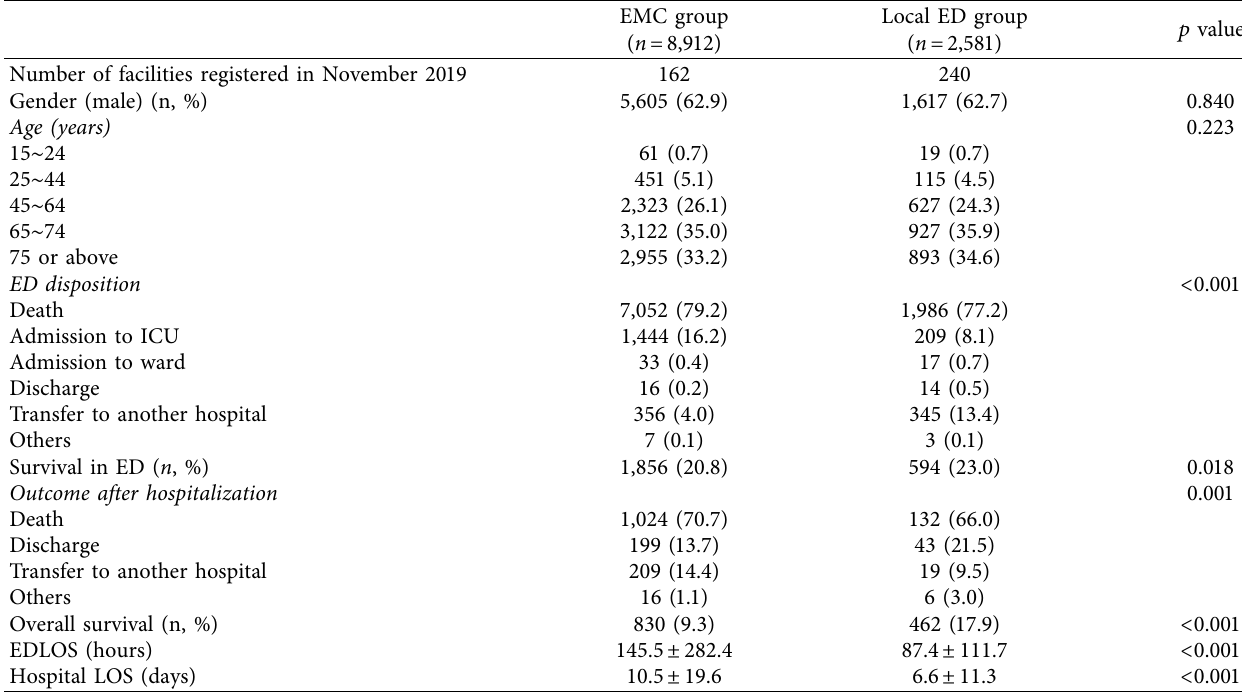
Table 1: Characteristics of patients arrived in out-hospital cardiac arrest and received cardiopulmonary resuscitation in the emergency medical institutions. Values are presented in counts and percentages in